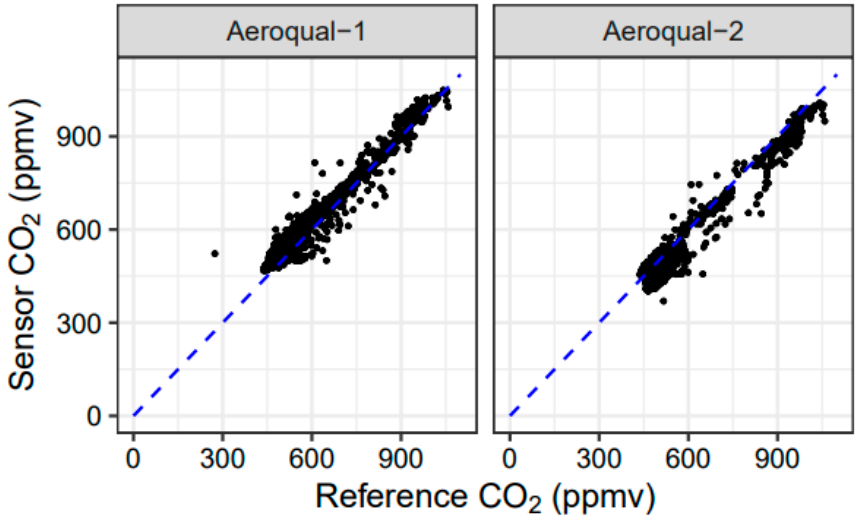
Figure 10. Scatterplot of sensor CO 2 measurements versus reference CO 2 measurements for 33 experimental burns at the Fire Sciences Laboratory in 2018.